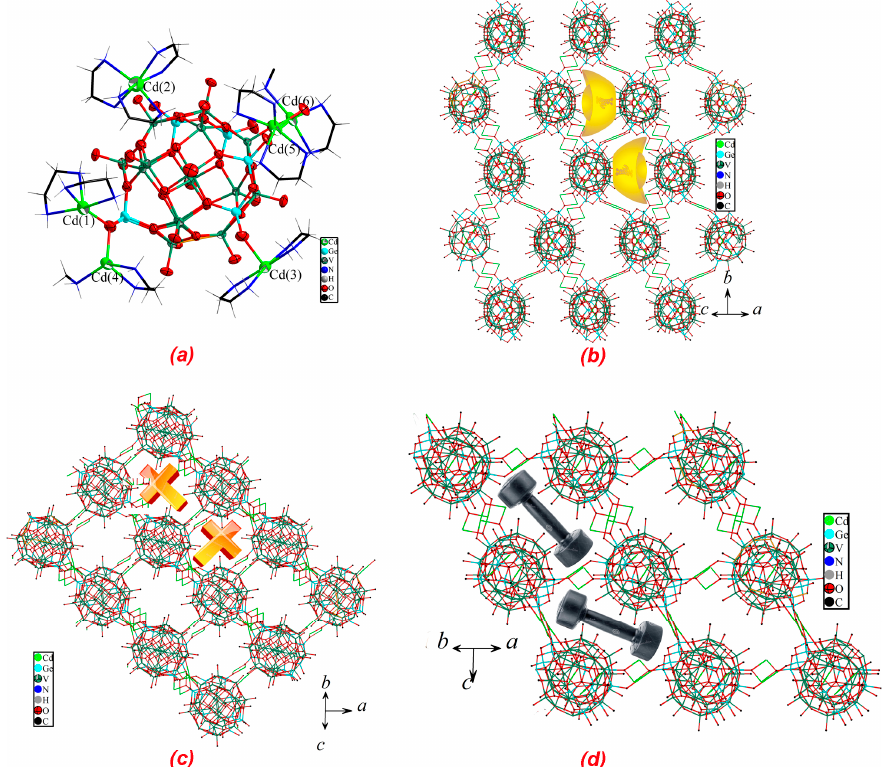
Figure 3. ( a ) Ball-and-stick and wire representation of the [Ge 6 V 15 O 48 ] 12 − cluster and five different types of TMCs in compound 3; ( b ) the framework structure viewed along [101]; ( c ) the framework structure viewed along [011]; ( d ) the framework structure viewed along [110].